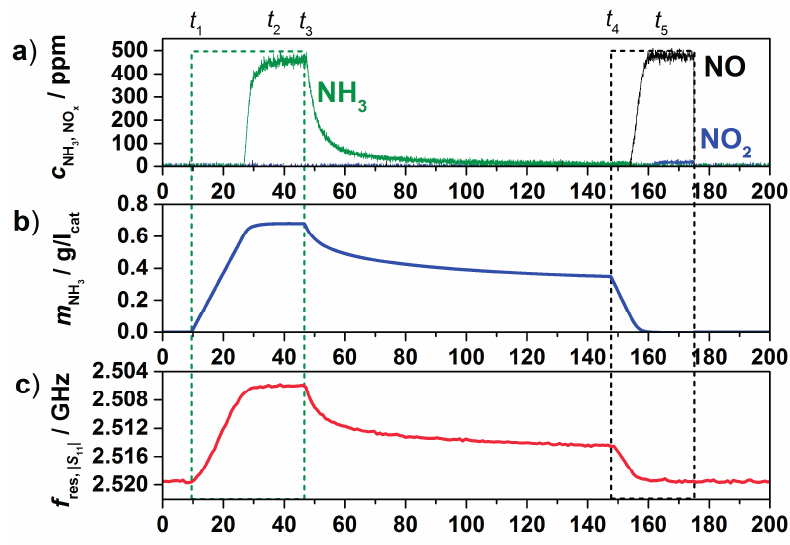
Figure 13. Cu-SSZ-13 honeycomb catalyst: NH 3 storage measurement at 250 °C; ( a ) inlet (dashed lines) and outlet (solid lines) gas concentrations of NH 3 (green), NO (black) and NO 2 (blue); ( b ) calculated amount of NH 3 stored on the catalyst; and ( c ) resonance frequency of the TE 111 mode. Modified after [27], with permission from